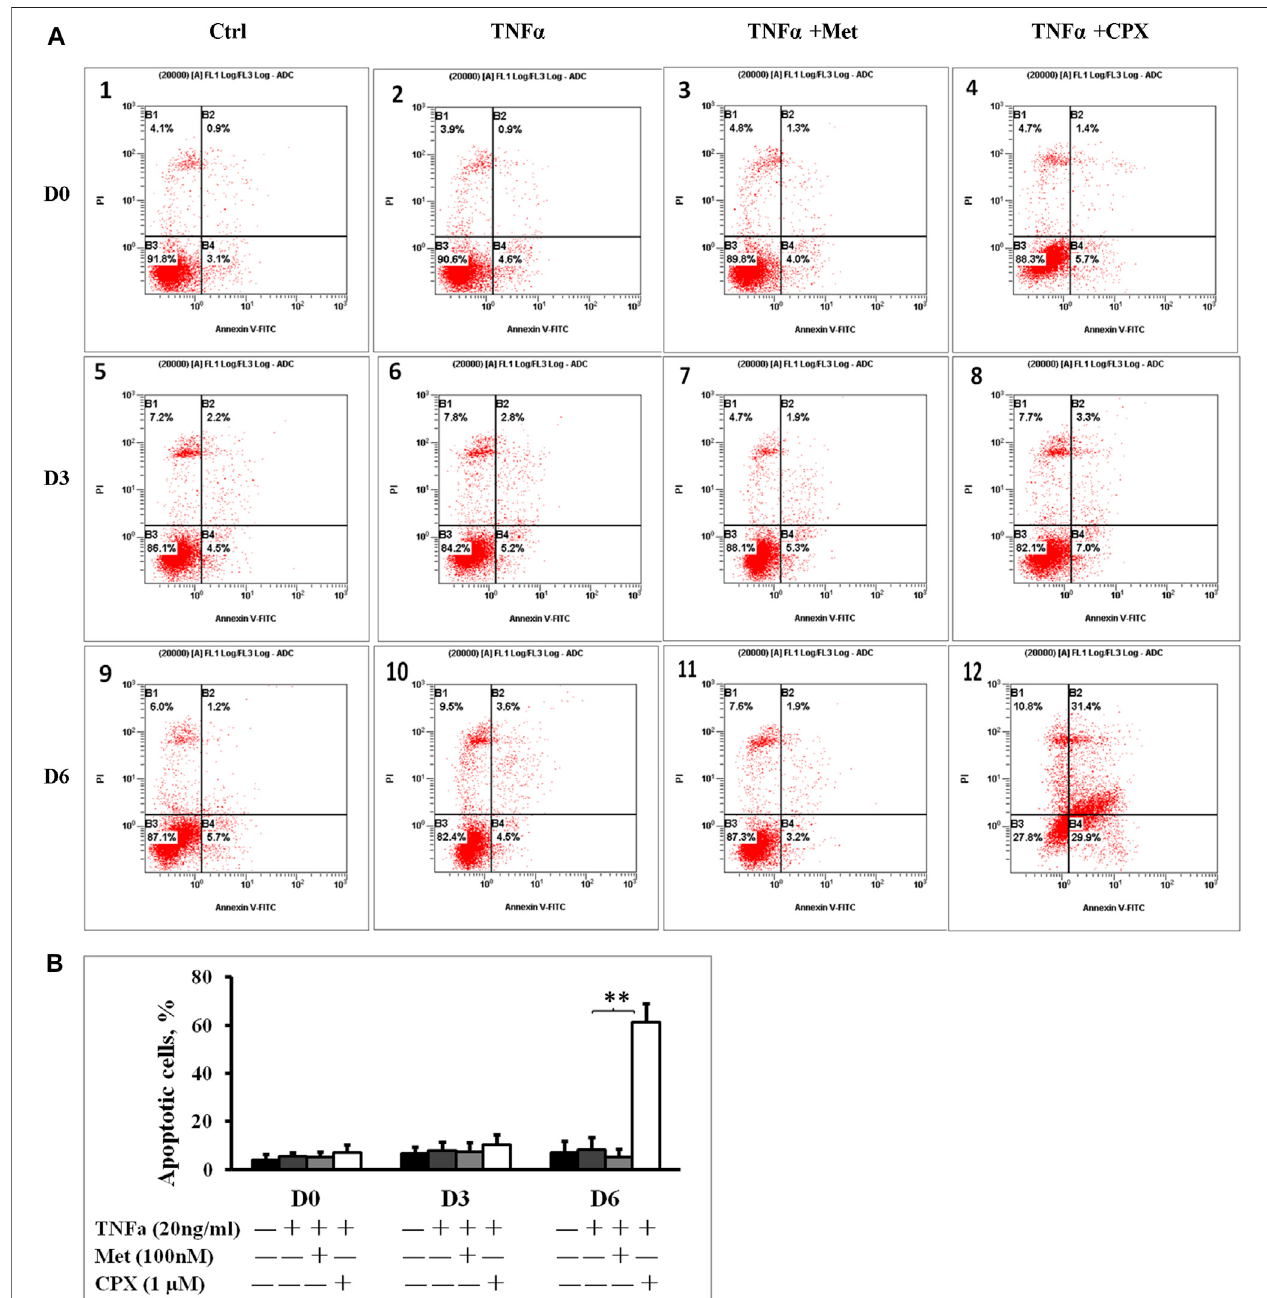
FIGURE 3 | Inhibition of histamine H 3 receptor enhances apoptosis. (A) : C2C12 cells were incubated in the presence of TNFa (20 ng/ml), TNFa + Met (100 nM) or TNFa + CPX (1 µM) at D0, D3, or D6. Apoptotic cells were detected by Annexin V and propidium iodide staining and analyzed by fl ow cytometry: percentage of cells mechanically damaged (top left quadrant) , live cells (bottom left) , early apoptotic cells (bottom right) , late apoptotic cells (top right) . (B) : Percentage of apoptotic cells was calculated by adding the early and the late apoptotic cells for each experimental condition. ** p < 0.01 vs. TNF α of the same differentiation day (dark gray columns). Ctrl, control; TNFa, murine Tumor Necrosis Factor-alpha; Met, methimepip; CPX, ciproxifan. D0, undifferentiated cells; D3, cells differentiated for 3 days; D6, cells differentiated for 6 days.